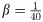
Comparison of 3D segmentation output with and without the ‘neighbour’ information.(a)-(b) 3D segmentation output using the ‘mixtures’ method, which is equivalent to our MRF based method with λ
0 = λ
1 = 0. (c)-(d) 3D segmentation output using our MRF based method with λ
0 = mini, l
u
i;l, λ
1 = maxi, l
u
i;l − λ
0 and β=140. The blue and magenta arrows indicate areas where the MRF method produces a smoother segmentation. See S2 Video for a video of the 3D segmentation output.